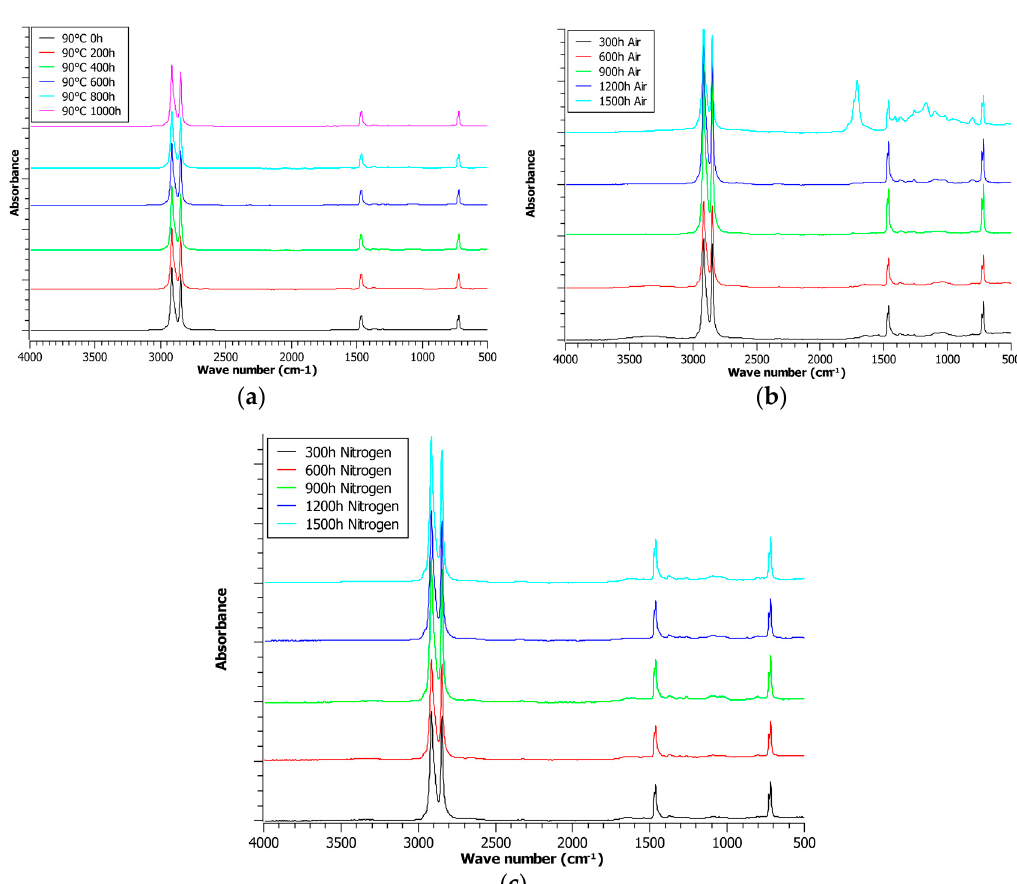
Figure 4. FT-IR measurements for different aging time in air ( a ) 90 °C aging; ( b ) 110 °C aging, and in nitrogen ( c ) 110 °C aging.